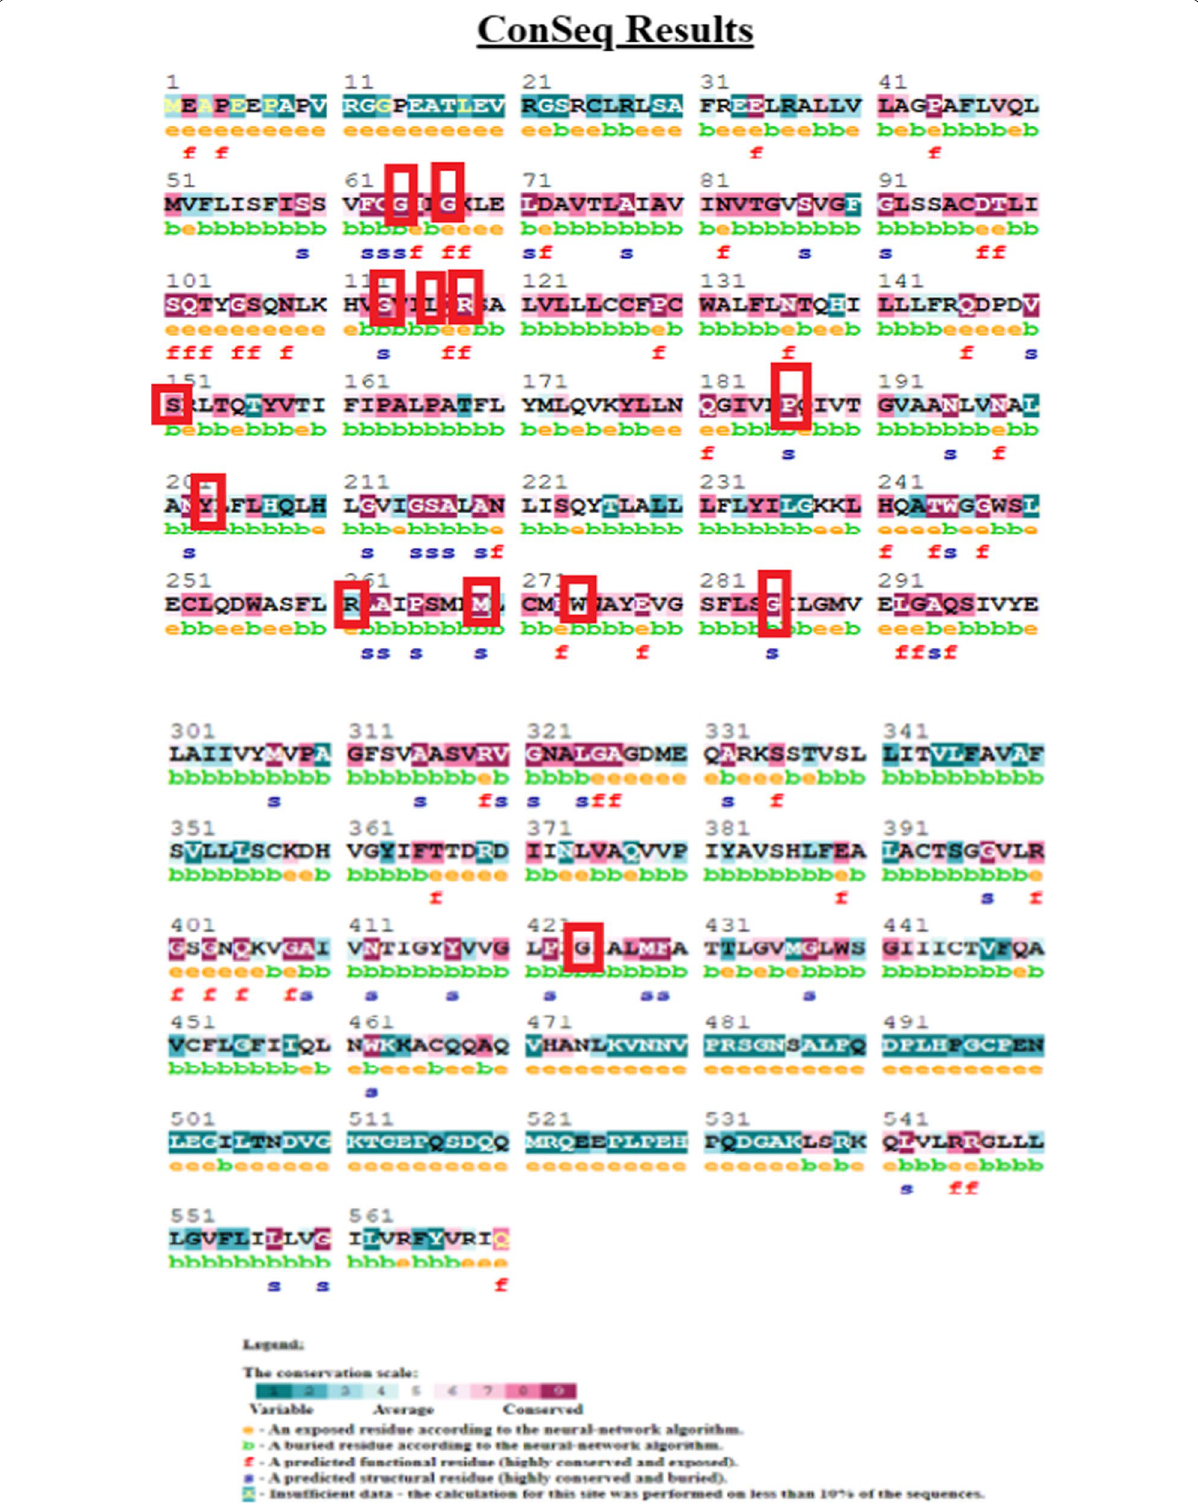
Fig. 1 Evolutionary conservancy of MATE1 generated by